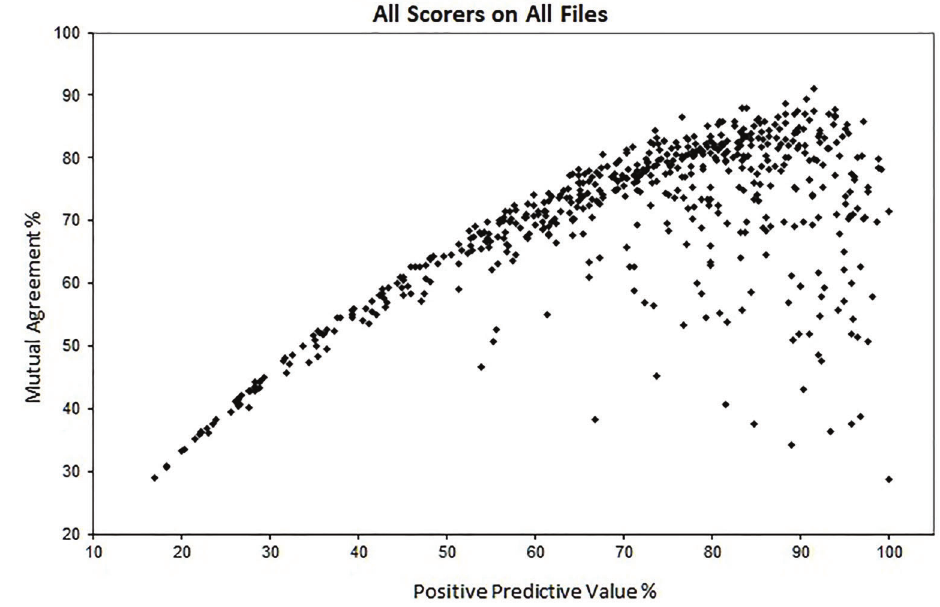
Figure 4. Mutual agreement scatter plot versus positive predictive value for all pairwise fi le-by- fi le comparisons.